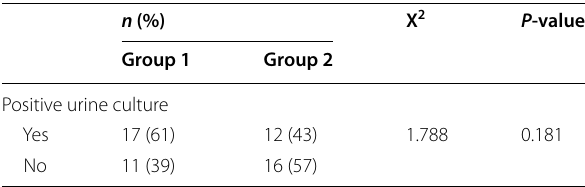
Table 2 Chi-square test analysis showing the level of association in the presence of positive post-biopsy urine culture